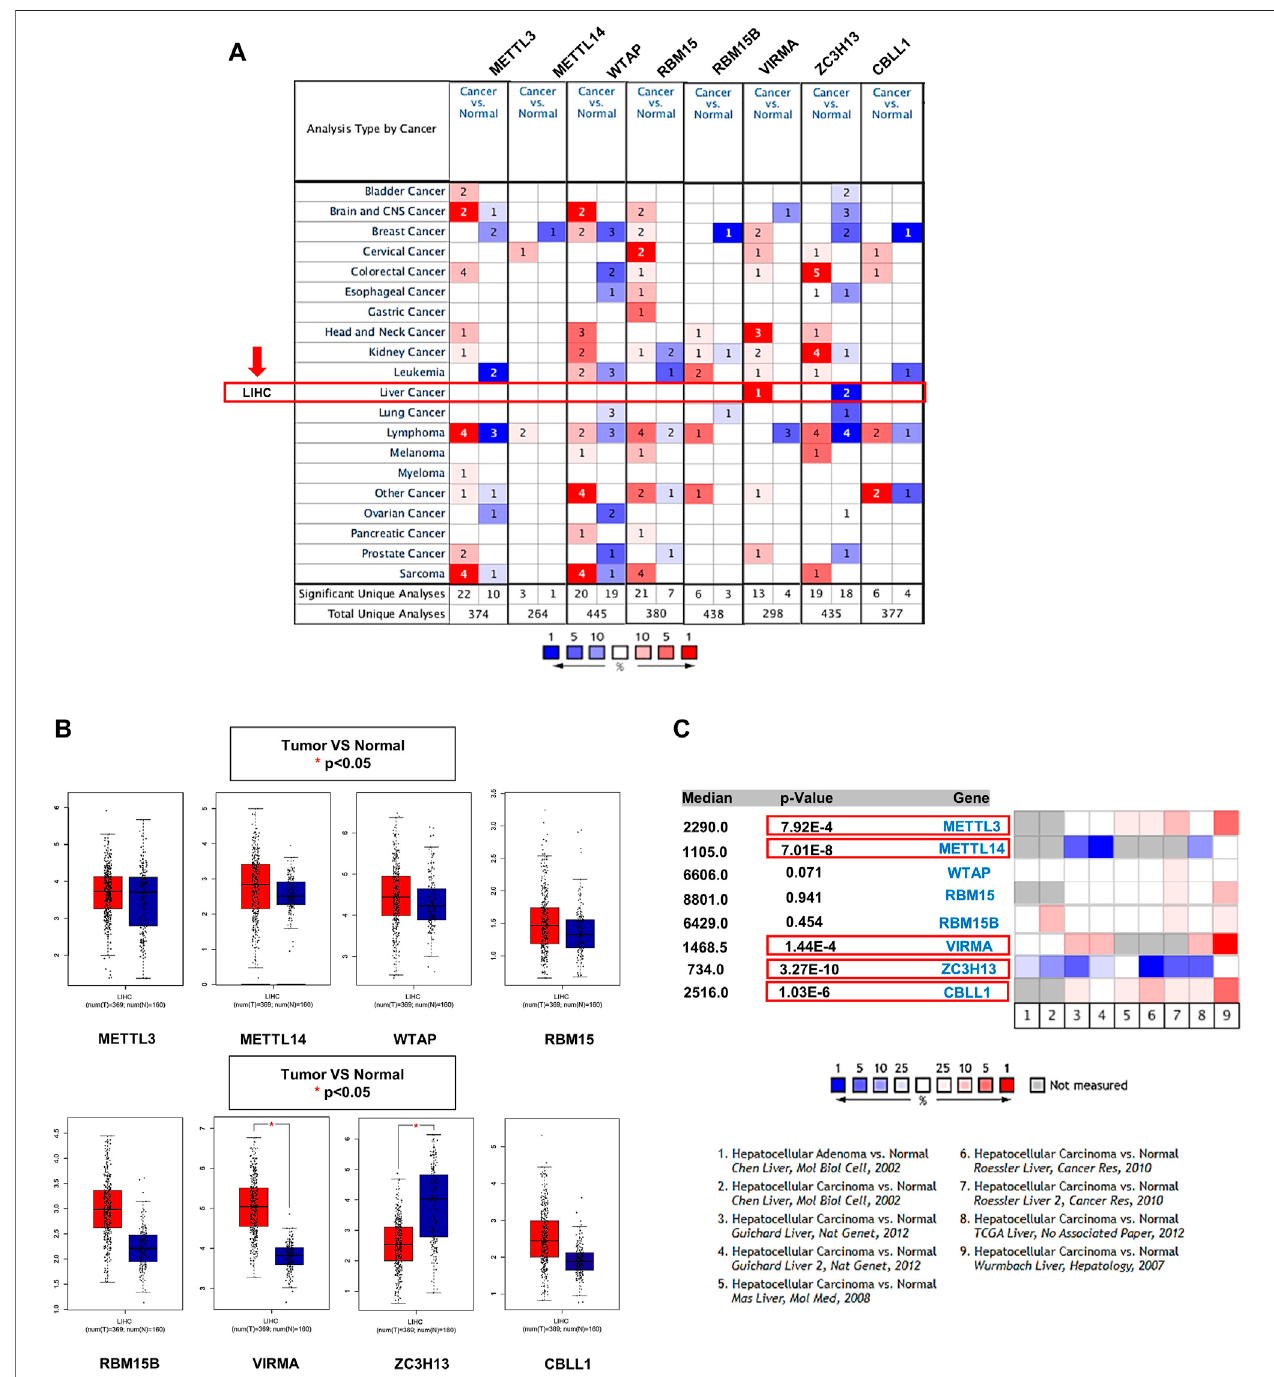
FIGURE 2 | Transcriptional levels of the m 6 A writer complex in HCC. (A) mRNA expression levels of the m 6 A writer complex (Oncomine). The box indicated by the red arrow shows liver hepatocellular carcinoma (LIHC). The colored squares represent the median rank of these genes (vs. normal tissue). Red represents high expressionandbluerepresentslowexpression.DifferencesintranscriptionalexpressionwerecomparedusingStudent ’ st-test.Thecutoff p -valueandfoldchangewere as follows: p -value: 0.01, fold change: 1.5, gene rank: 10%, data type: mRNA. (B) Box plot of m 6 A writer complex expression in HCC (GEPIA). Red represents the expression in HCC tissue, and blue represents the expression in normal tissue. * p < 0.05. (C) Meta-analysis of the mRNA expression levels of the m 6 A writer complex using the nine Oncomine datasets. The colored squares represent the median rank of these genes (vs. normal tissue) across the nine datasets. Red represents high expression and blue represents low expression. The signi fi cance level for the median rank analysis was set at p < 0.05.